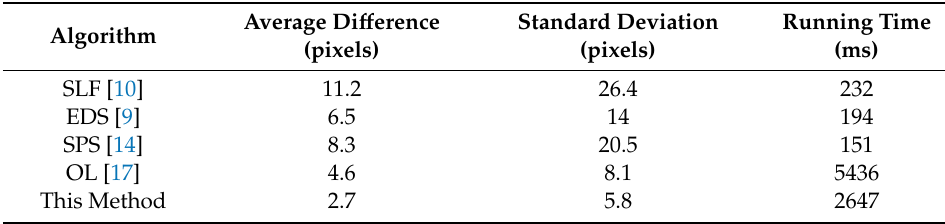
Table 4. WSL detection performance